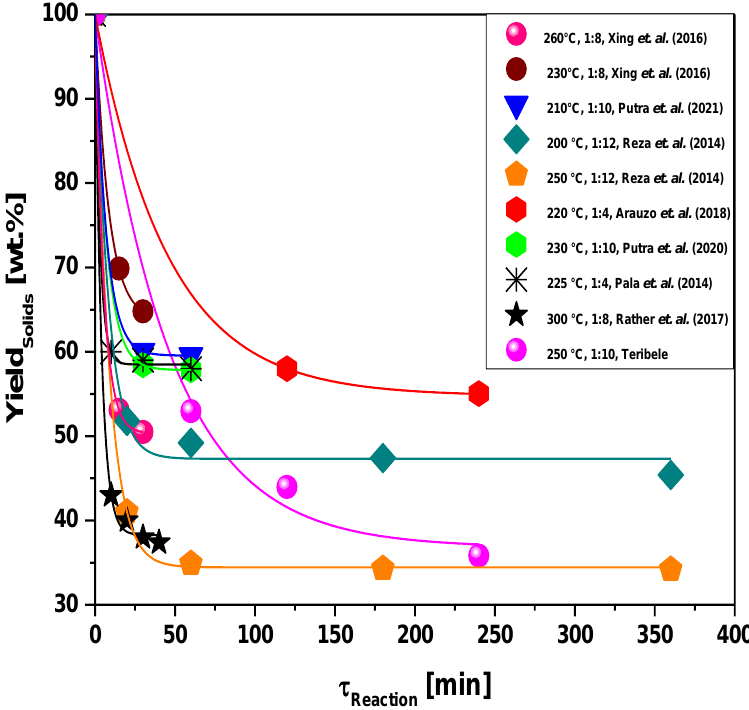
Figure 16. Kinetics of corn stover degradation by hydrothermal processing of corn stover at 250 ◦ C with a biomass/H 2 O ratio of 1:10 after 60, 120 and 240 min using a reactor of 18.75 L compared with similar kinetic data reported in the literature [33,34,36,40,44,60,74,77]. Table 6. Regression of experimental kinetic data for the yield of hydro-char obtained by hydrother- The constant A, defined as [𝑎/𝑀 𝑆𝑜𝑙𝑖𝑑𝑠 ( )] , is a correction term, exhibiting a root- mal processing of corn stover with hot-compressed H 2 O at 250 ◦ C with a biomass-to-H 2 O ra- tio of 1:10 after 240 min using Equation (16) compared with similar kinetic data reported in the literature